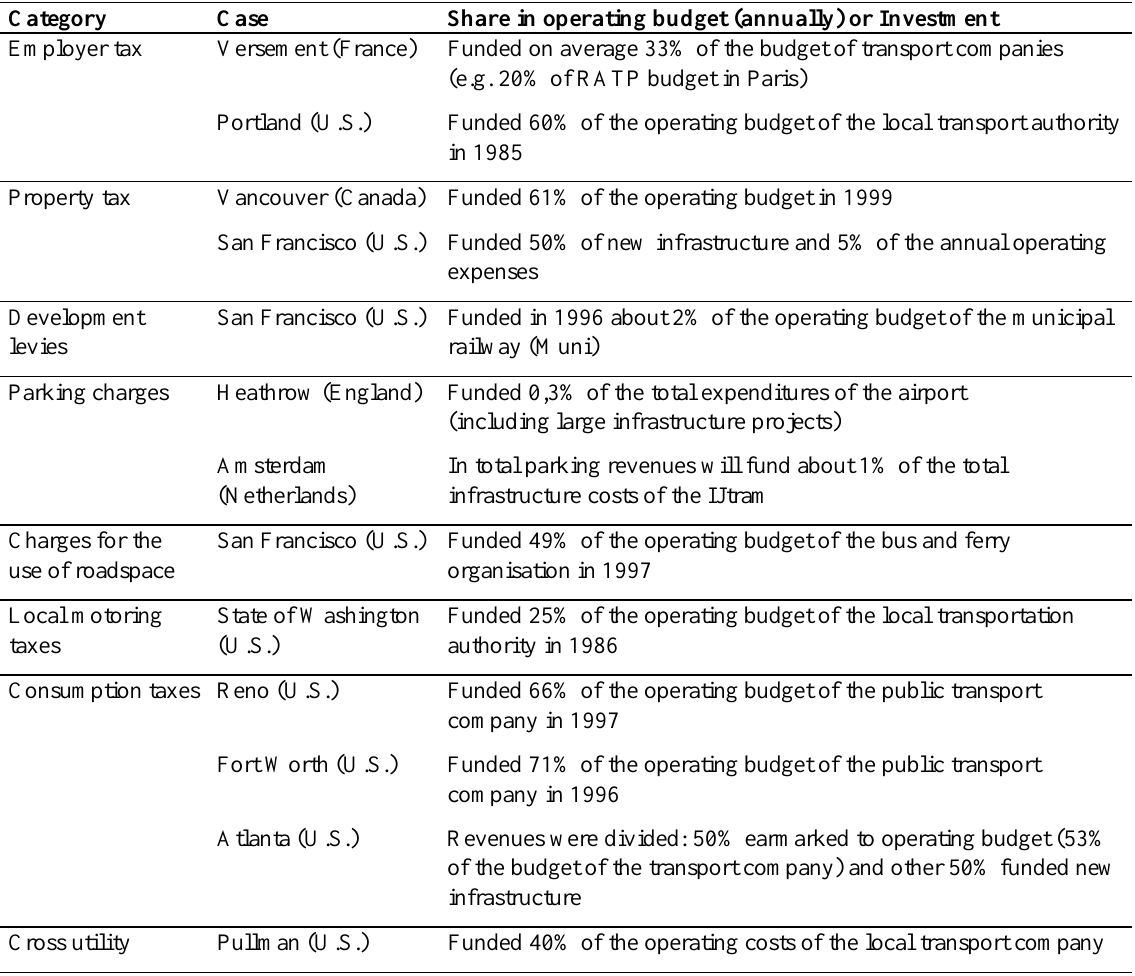
Table 1. Share of alternative funds in public transport budget or